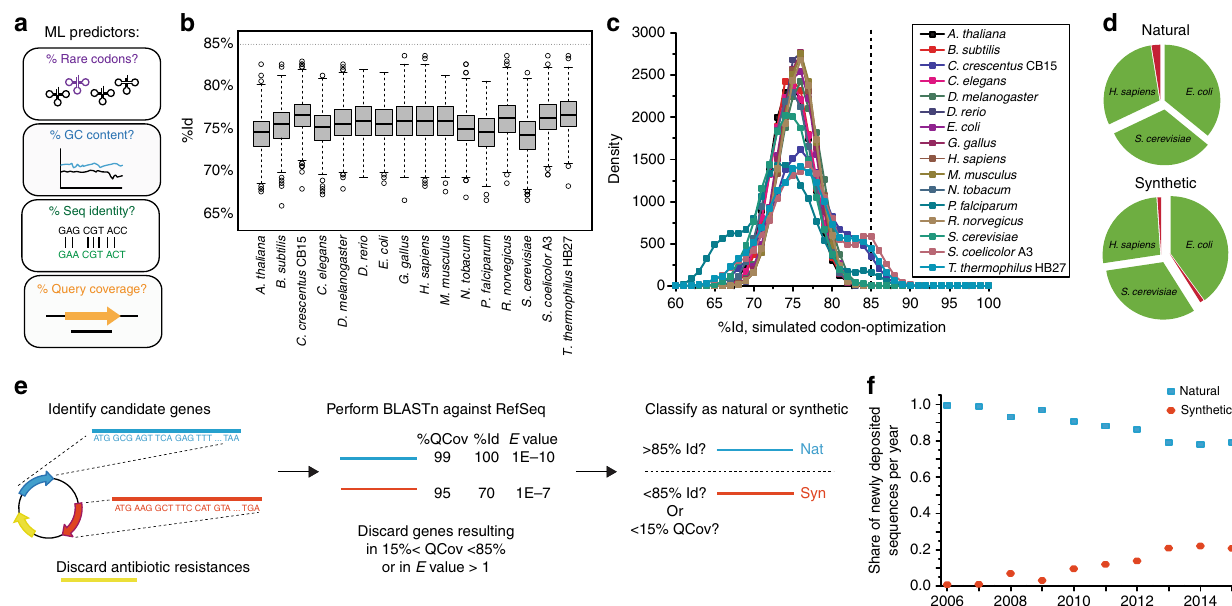
Fig. 2 A nucleotide-based sequence classi fi cation scheme for determining natural and synthetic gene sequences. a Cartoon depicting different machine learning input variables that were tested as possible predictors. b Simulated sequence percentage identity (%Id) of a codon-optimized sequence originating from 16 organisms (including model organisms and organisms with distinct codon usage) for expression in H. sapiens . Shown is the median, surrounded by the gray interquartile range, with whiskers extending to 1.5x the interquartile range, and circles for outliers. c Simulated %Id resulting from pair-wise codon- optimization of a hypothetical sequence for all 16 organisms and aggregating by expression organism. d Results from application of classi fi cation scheme to a manually constructed test set of natural ( N = 78) and synthetic ( N = 95) gene sequences for expression in Escherichia coli , Saccharomyces cerevisiae (baker ’ s yeast), and Homo sapiens . Regions colored in green represent the proportion of sequences successfully identi fi ed by our classi fi cation scheme, and regions in red represent unsuccessful cases. e Overall classi fi cation work fl ow. f Share of natural and synthetic sequences deposited to the